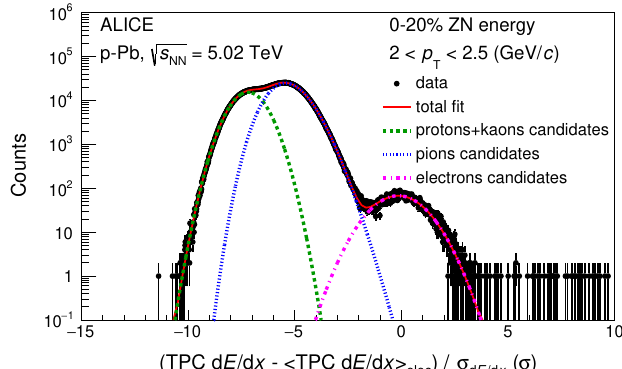
Figure 2 . The measured d E /d x in the TPC expressed as a standard deviation from the expected energy loss of electrons, normalised by the energy-loss resolution ( (cid:27) TPC ) for 2 < p T < 2 : 5 GeV =c . The various curves are the di(cid:11)erent (cid:12)t function results for the di(cid:11)erent peaks of the distribution. A Gaussian distribution, centered around zero, describes the electron candidates, and the pions and protons are the curves around n TPC (cid:27)